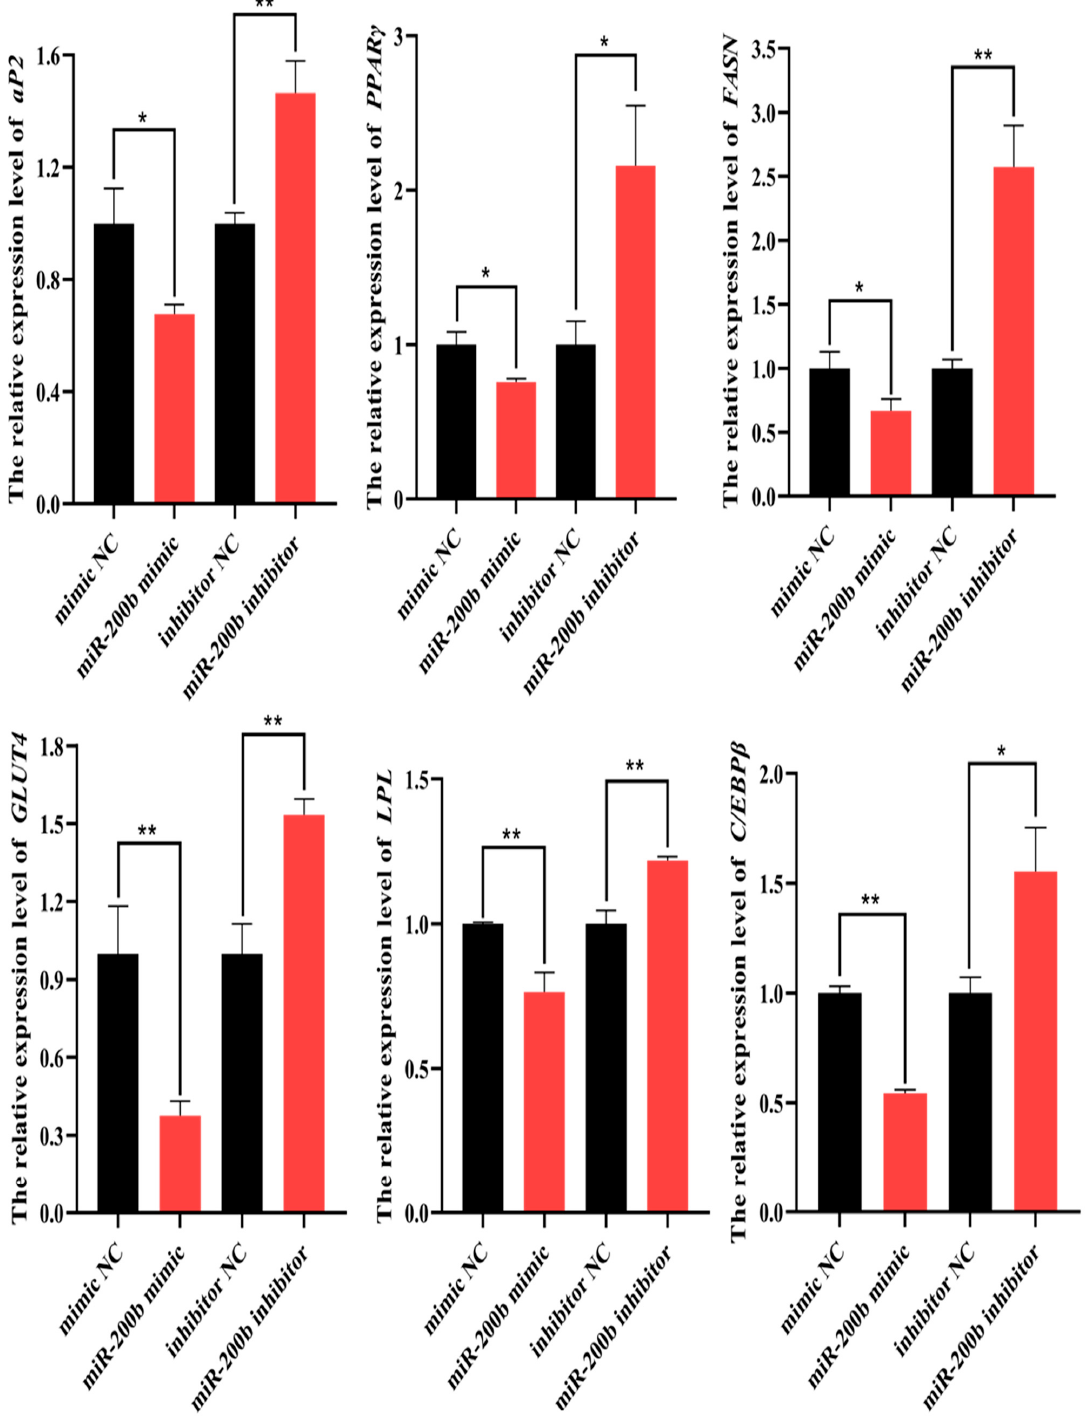
Figure 5. The expression levels of aP2 , PPAR γ , FASN , GLUT4 , LPL and C/EBP β in ovine adipocytes on day 8 after transfection with miR-200b mimic, miR-200b inhibitor and NC. The values represent mean ± SD ( n = 3), * p < 0.05, ** p < 0.01. 3.4. MiR-200b Targets the 3 (cid:48) UTR Region of p27 and KLF9 The wild-type and mutant-type dual luciferase reporter vectors for p27 -3 (cid:48) UTR and KLF9 -3 (cid:48) UTR were structured (Figure 6A). The dual luciferase reporter assay showed that miR-200b mimic significantly decreased the luciferase activity of p27 and KLF9 in HEK293 cells transfected with wild-type dual luciferase reporter vectors when compared to